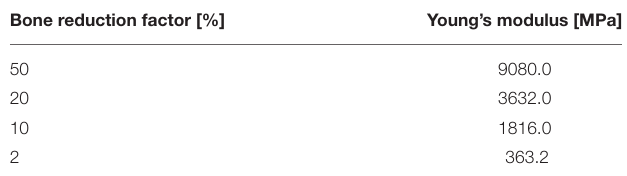
TABLE 2 | Mechanical properties of bone callus for different assumed bone reduction factors.